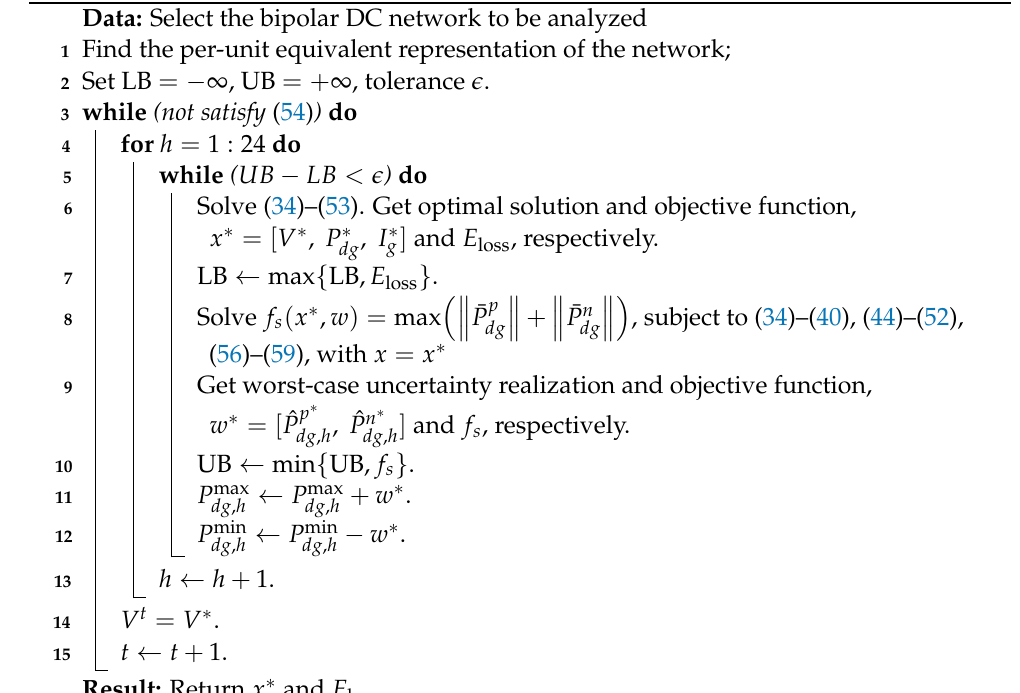
Algorithm 1: Robust Recursive Quadratic Convex Algorithm